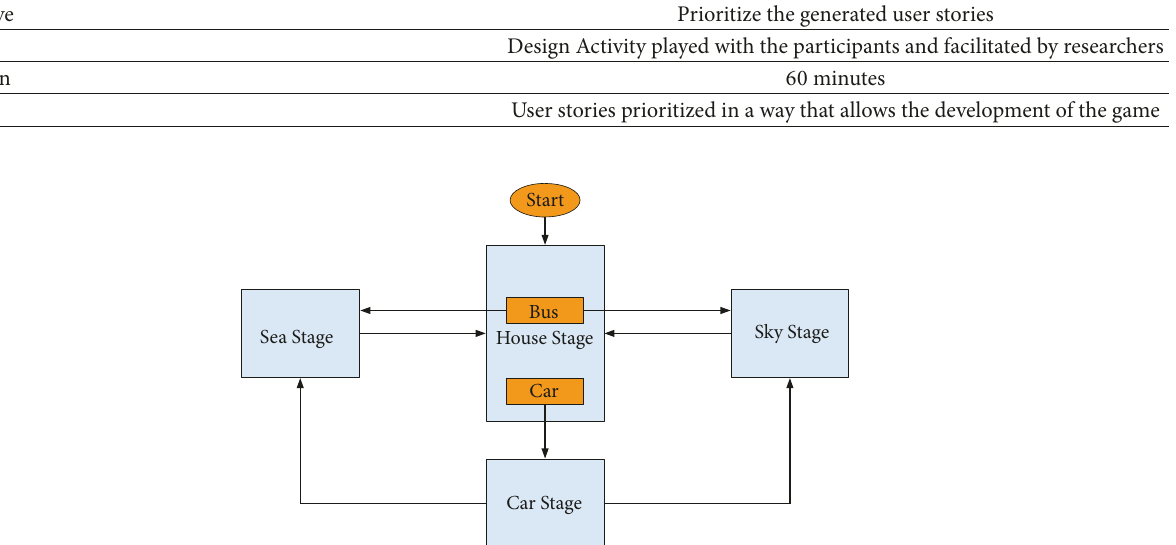
Figure 4: Possible flow between stages: the player can choose to go directly to stages Sea or Sky by taking the bus or drive to them by passing through the Street stage.